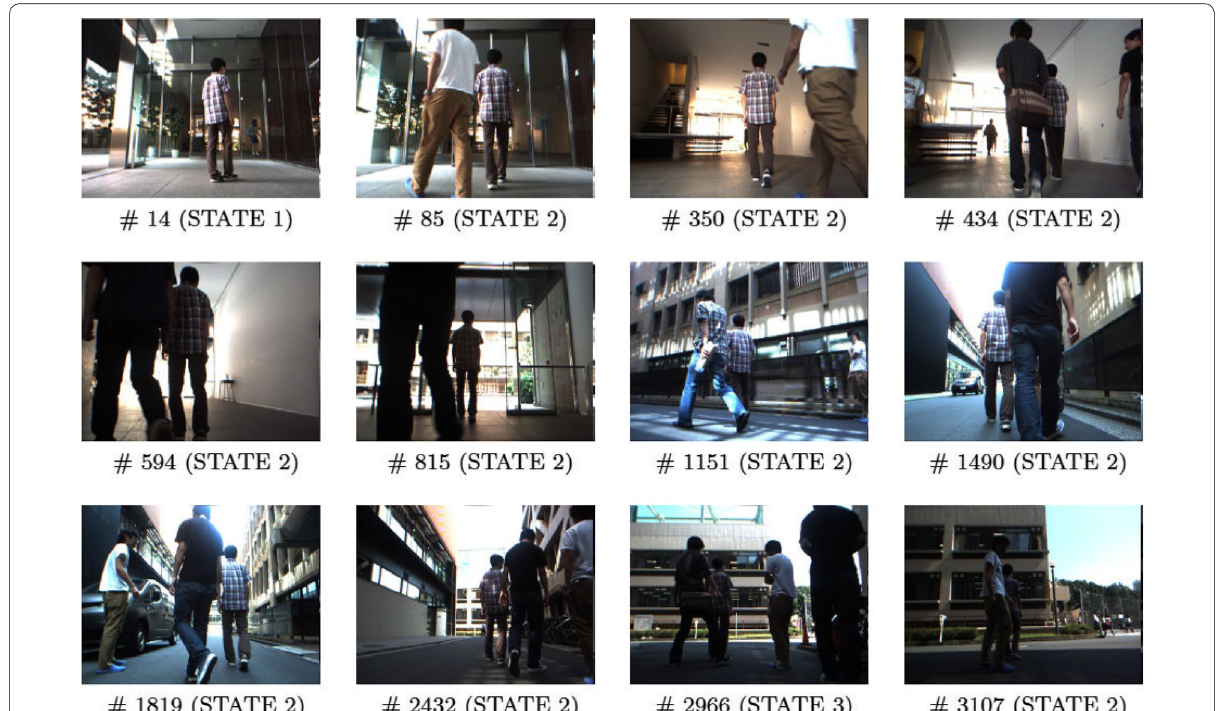
Fig. 10 Captured color images used in off-line experiments. The frame number and occlusion state which is classified by using the proposed method, are shown under each